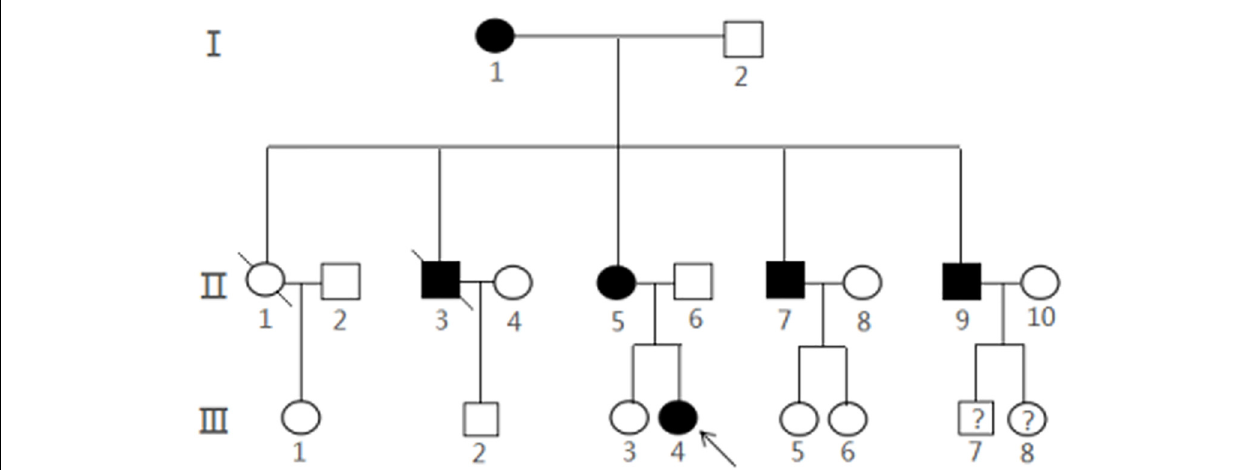
FIGURE 3 | Pedigree of a Chinese family with CCMs. The arrow represented the proband III4 and filled symbols represented family members with CCMs. Squares indicated males, and circles indicated female. An oblique line through the symbol demonstrated a deceased individual.Interrogation point represents that it is unknown whether the subject is a CCMs carrier.